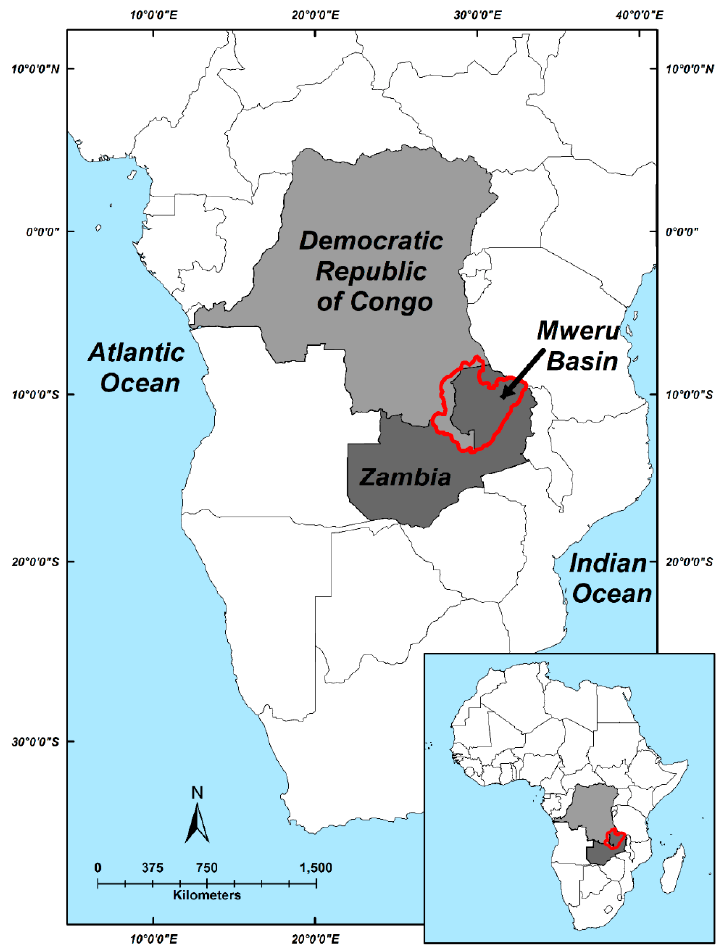
Figure 1. Location of the drainage basin feeding Lake Mweru, Zambia.